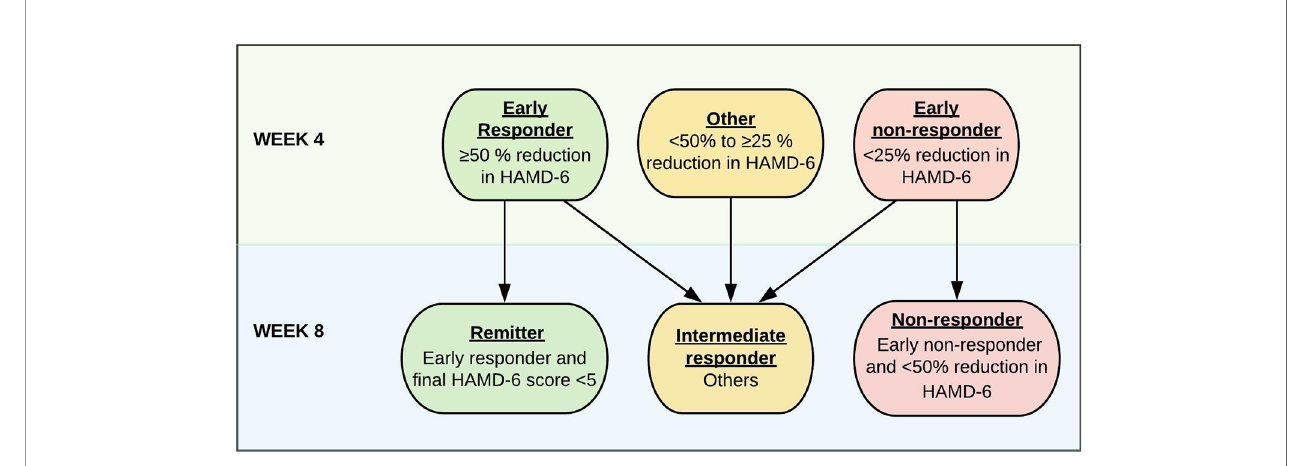
FIGURE 3 | Response categorization for patients with MDD after 4 and 8 weeks of antidepressant treatment based on changes in HAMD